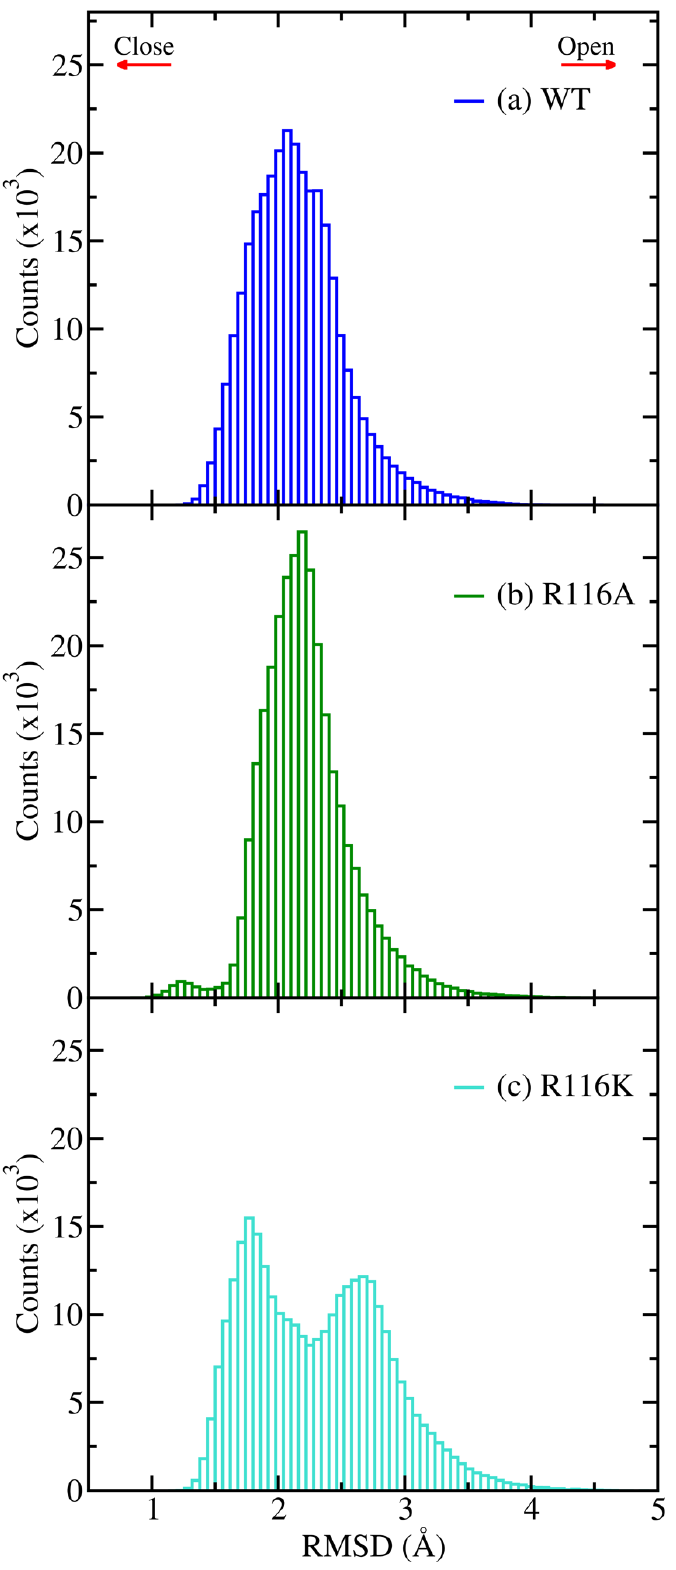
Figure 5. Distributions of “closed” and “open” conformations for ( a ) the WT, ( b ) R116A, and ( c ) R116K variants. Notice that mutants cover a broader interval than the WT and populations are shifted towards more “closed” states. The direction of “closed” and “open” conformations is indicated by the arrows.